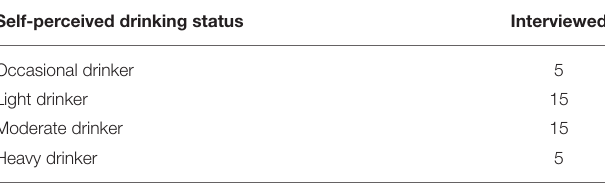
TABLE 1 | Sample characteristics by self-perceived alcohol